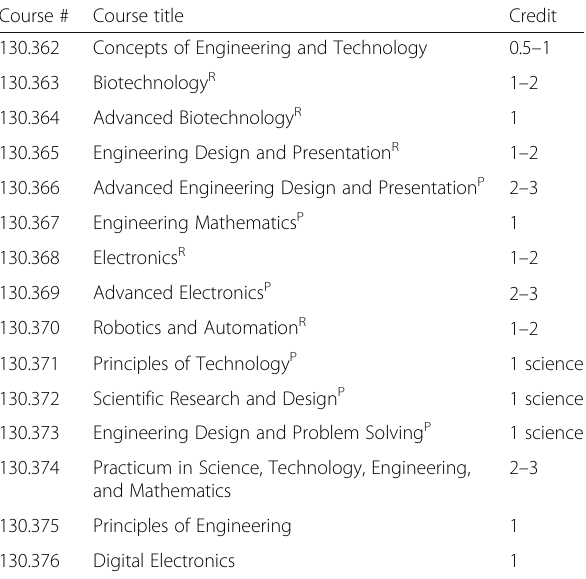
Table 2 CTE-STEM courses offered in Texas as of the 2014 –